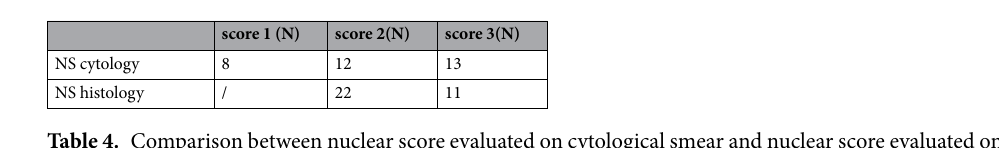
Table 3. Comparison between the distribution of Noninvasive follicular thyroid neoplasm with papillary-like nuclear features (NIFTP) in the cytological diagnostic classes according to SIAPEC-IAP 2014 system in our series, in Bizzarro et al . study and data from Bongiovanni et al . review 16,17,21 .